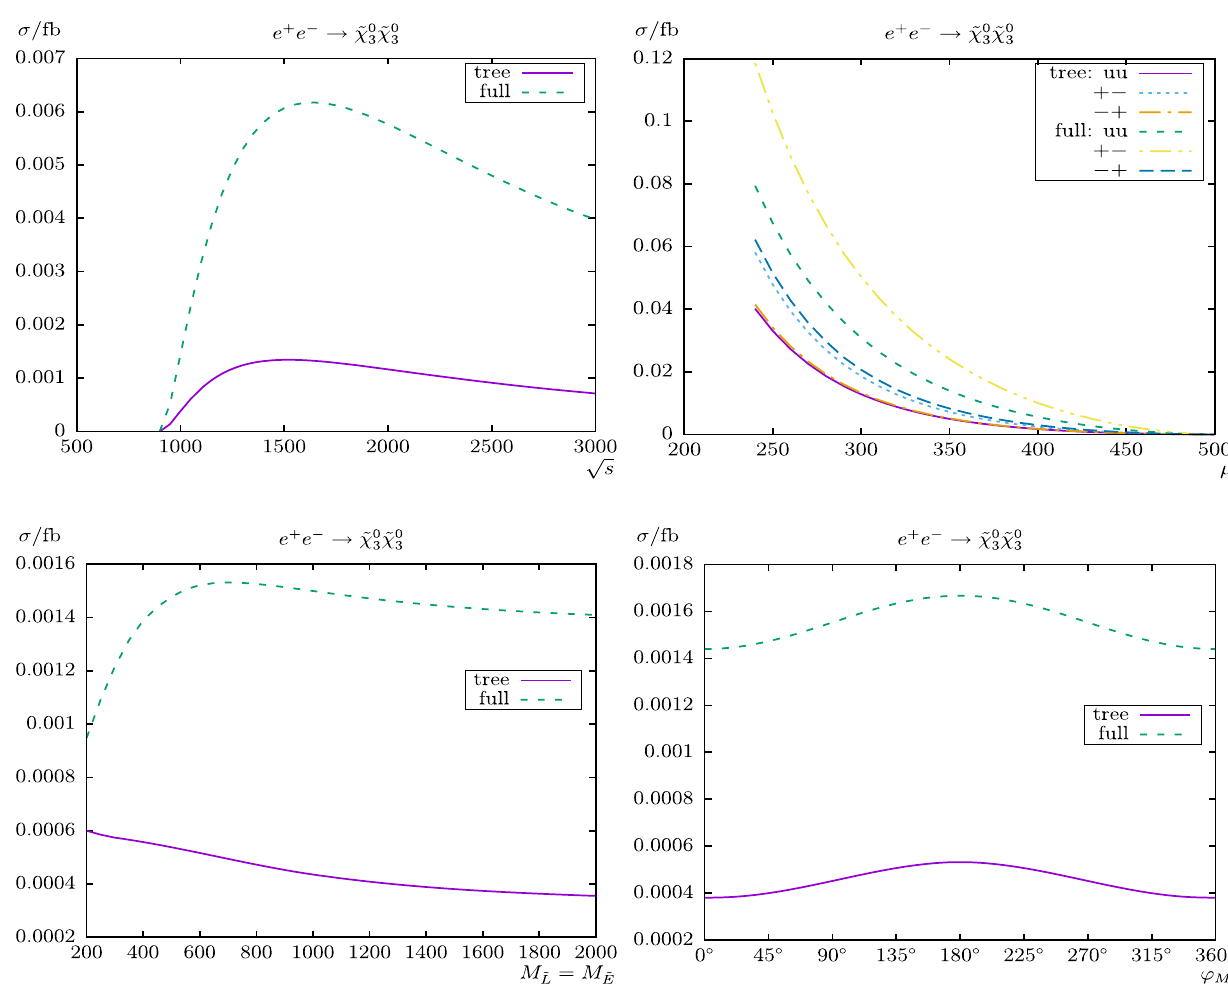
˜ χ 0 ) . Tree-level and full one-loop corrected 3 3